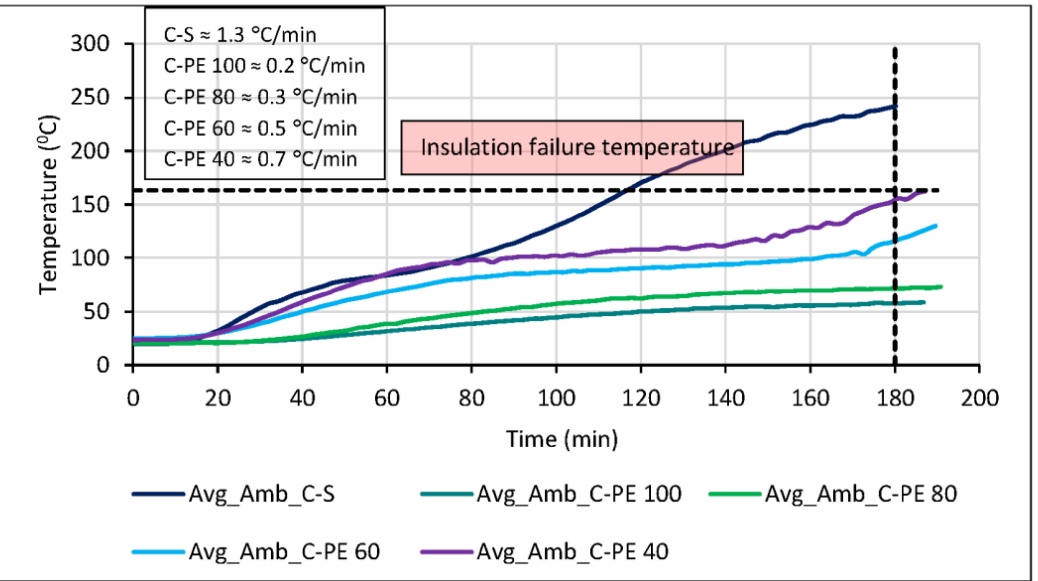
Figure 38. Comparison of the ambient side block surface temperatures from the building fire